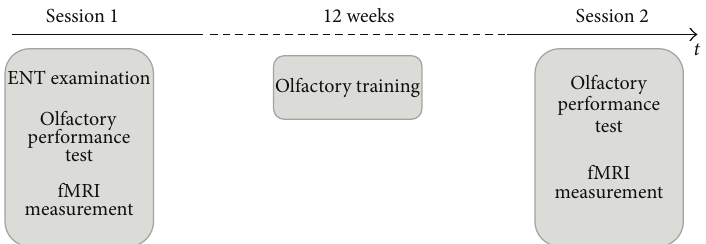
Figure 1: Schematic description of experimental